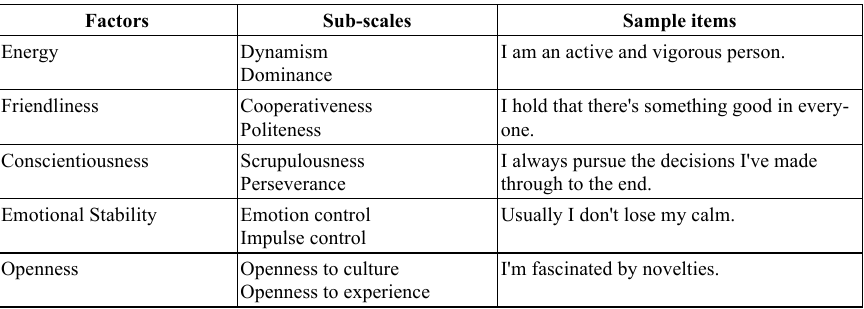
Table 1. Factors, sub-scales and sample items of the BFQ, based on [15] Factors Sub-scales Sample items Energy Dynamism